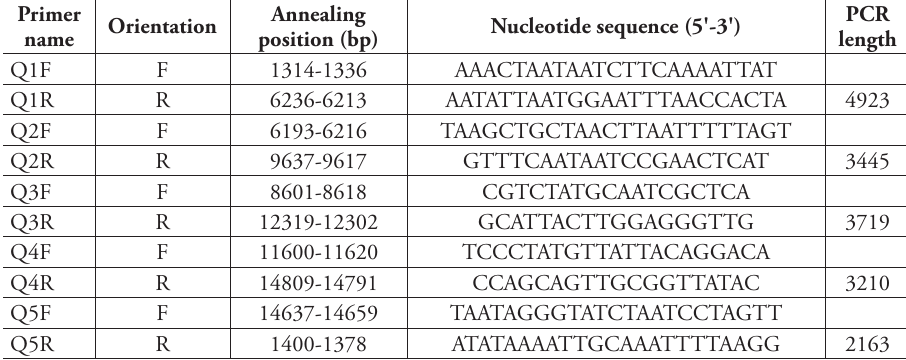
Table 1. Details of the primers used to amplify the mitochondrial DNA of T. japonica